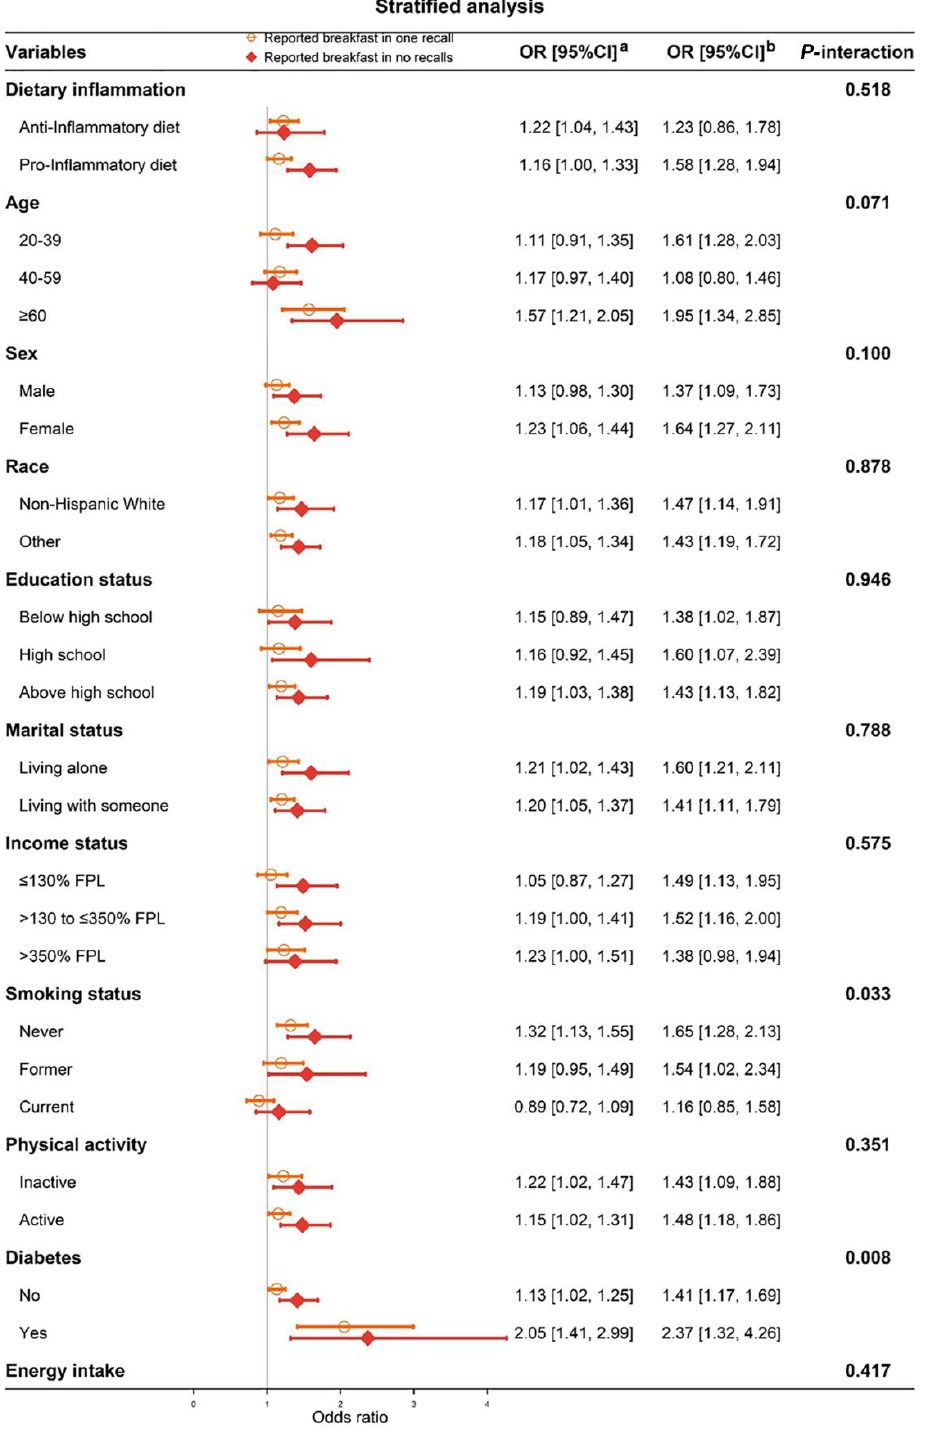
Figure 2. Forest plot of stratified analyses of the associations between Reported breakfast and obe-